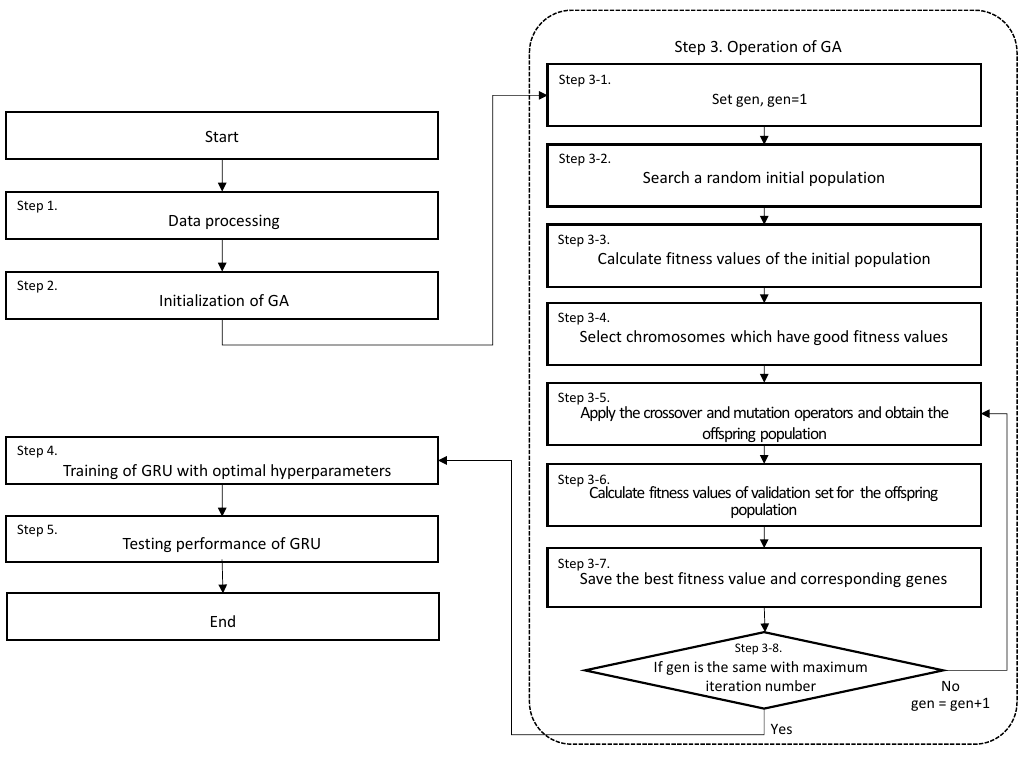
Figure 2. The flowchart of GA-GRU.